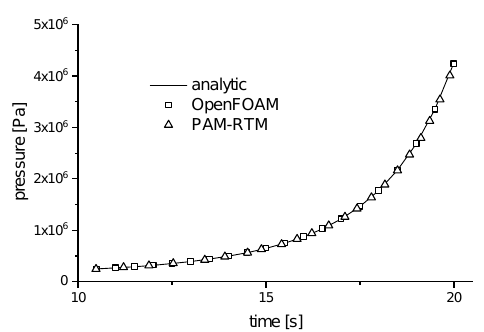
Figure 8. Pressure increase at the inlet (set to a wall boundary condition) while Compression-RTM boundary conditions are applied.